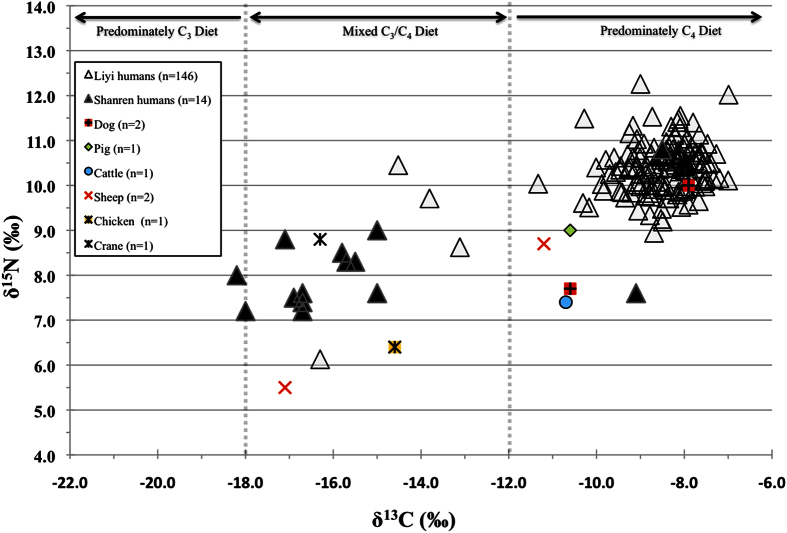
Human and animal δ13C and δ15N results from the Liyi and Shanren sites.